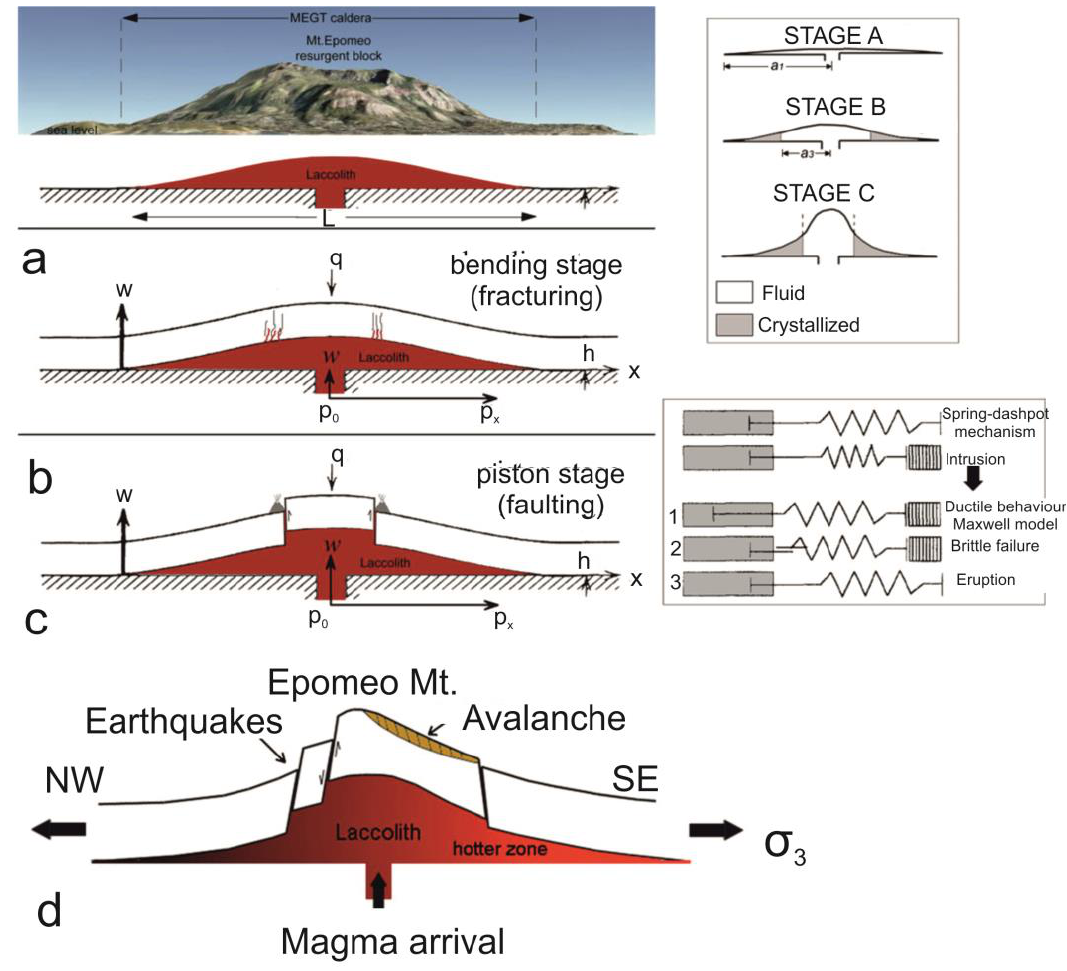
Figure 5. The laccolith model of Ischia constructed by Carlino [30] ( a , b , c ) and Carlino et al. [19] ( d ). w: plate uplift; p 0 : laccolith pressure; p x . laccolith pressure at phase x; q: average magma influx; L: length of the elastic plate; h: thickness of the elastic plate; σ3: minimum principal stress [30].